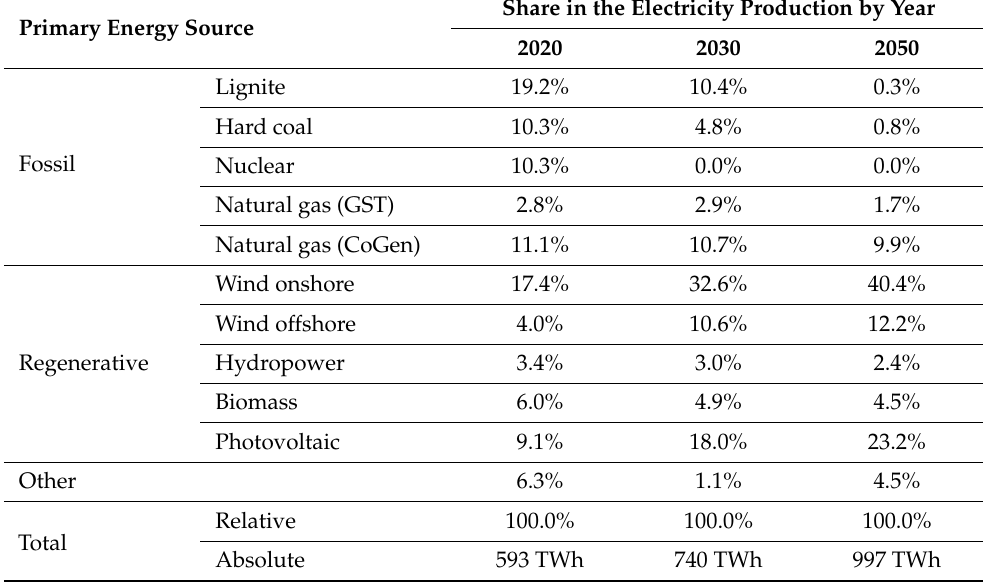
Table 9. Generation mix of German electricity